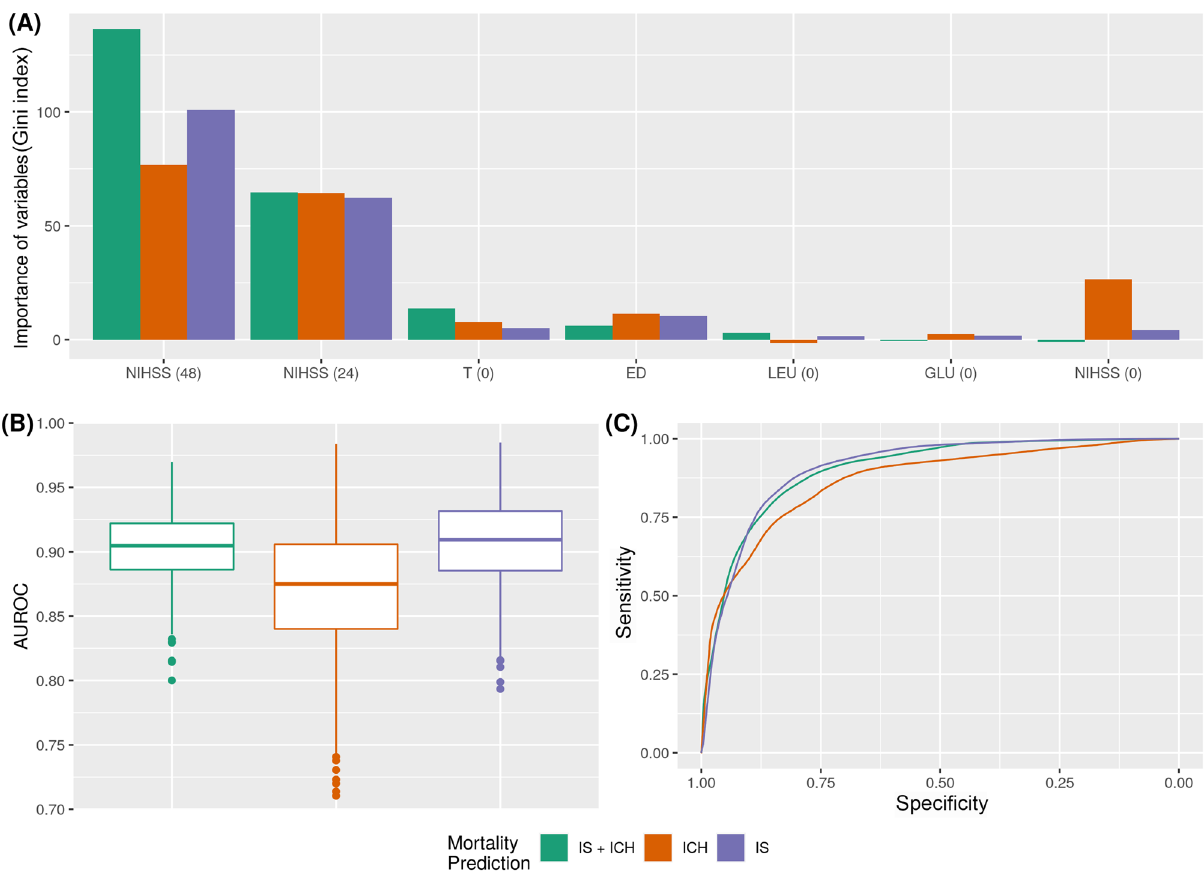
Figure 2. Mortality prediction for IS + ICH, IS and ICH groups . ( A ) Main variables for the machine learning model: NIHSS score at admission [NIHSS (0)]; NIHSS score at 24 h [NIHSS (24)]; NIHSS score at 48 h [NIHSS (48)]; Axillary temperature at admission [T(0)]; Early neurological deterioration [ED]; Leukocytes at admission [LEU (0)]; and Blood glucose at admission [GLU (0)]. ( B ) AUROC values obtained. (C) ROC curves for the Random Forest